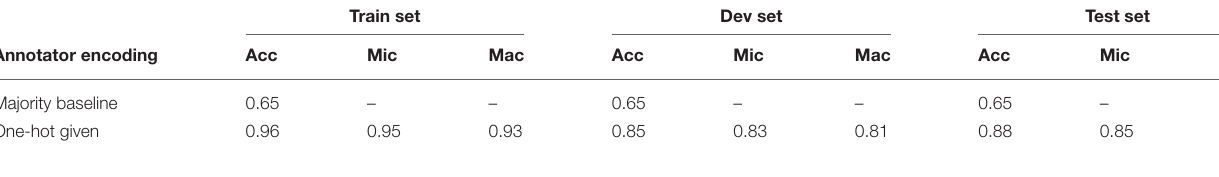
TABLE 9 | Accuracies on the unaggregated test sets after training on the unaggregated training sets.